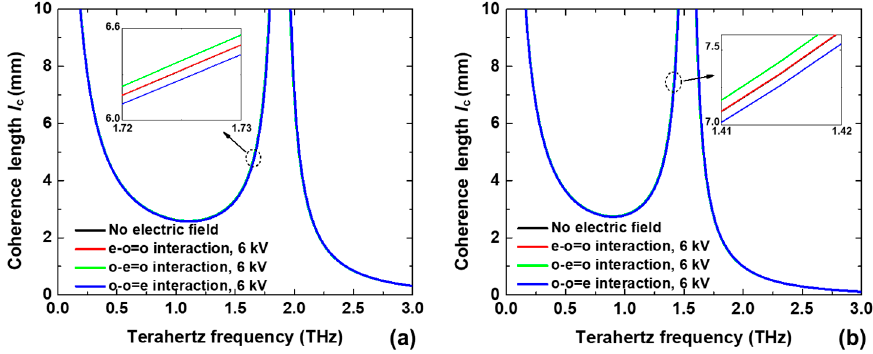
Figure 6. Coherence lengths of different OR interactions along the y ’ axis in the y’oz’ principal plane of ZnTe and CdTe with and without an applied voltage of 6 kV: ( a ) ZnTe crystal pumped at 800 nm and ( b ) CdTe crystal pumped at 1010 nm.